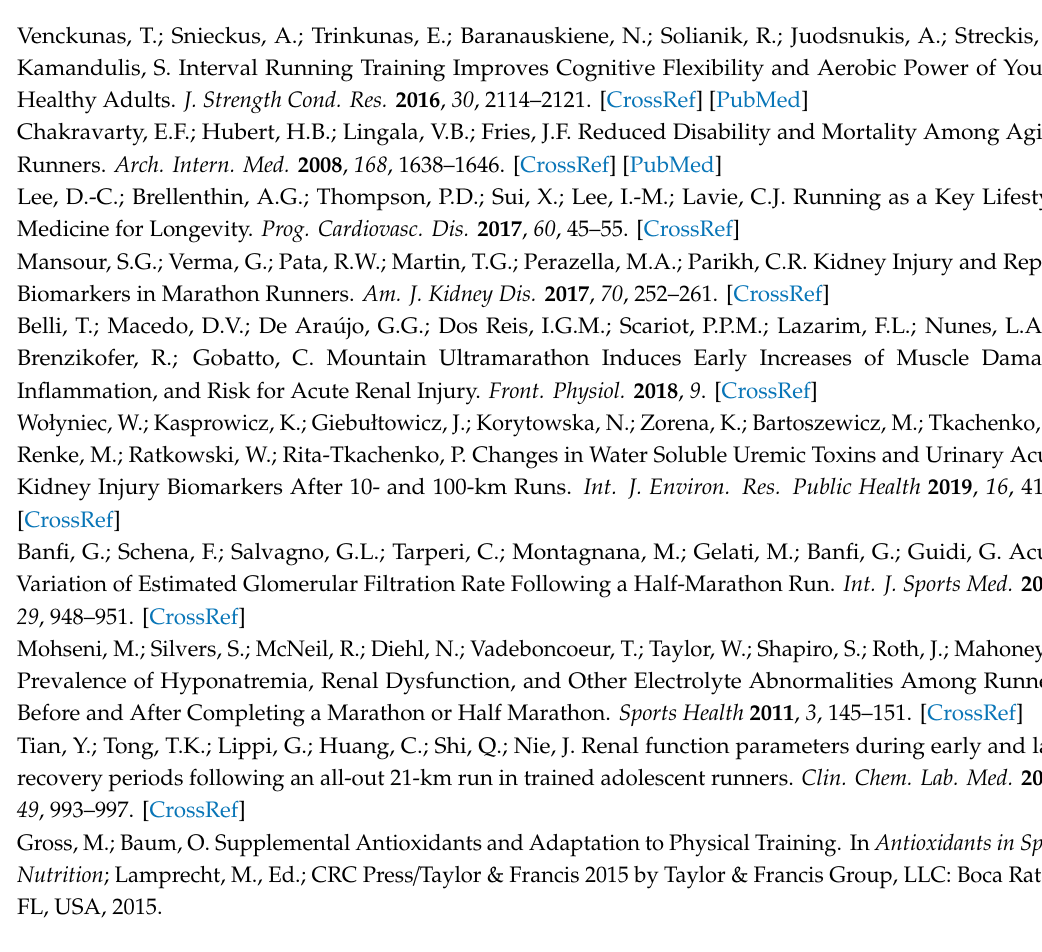
Table S1: Blood pressure and heart rate in recreational runners before and after the use of 400-mg single-dose ibuprofen followed by completion of the half-marathon. Table S2: Parameters assessed with the urine dipstick test in recreational runners before and after the use of 400-mg single-dose ibuprofen followed by completion of the half-marathon. Table S3: Urinary biomarkers in recreational runners before and after the use of 400-mg single-dose ibuprofen followed by completion of the